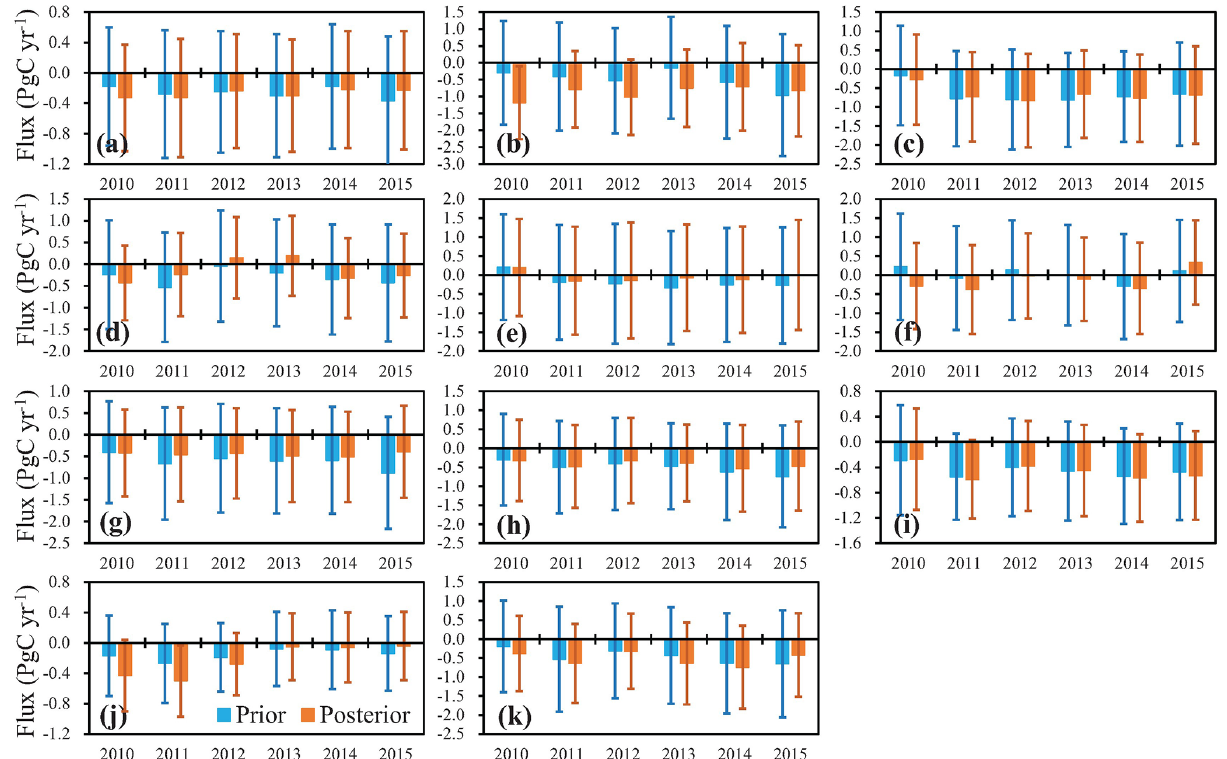
Figure 11. Prior and posterior interannual variations in the BIO fluxes for (a) boreal North America, (b) temperate North America, (c) tropical South America, (d) temperate South America, (e) northern Africa, (f) southern Africa, (g) boreal Asia, (h) temperate Asia, (i) tropical Asia, (j) Australia, and (k)